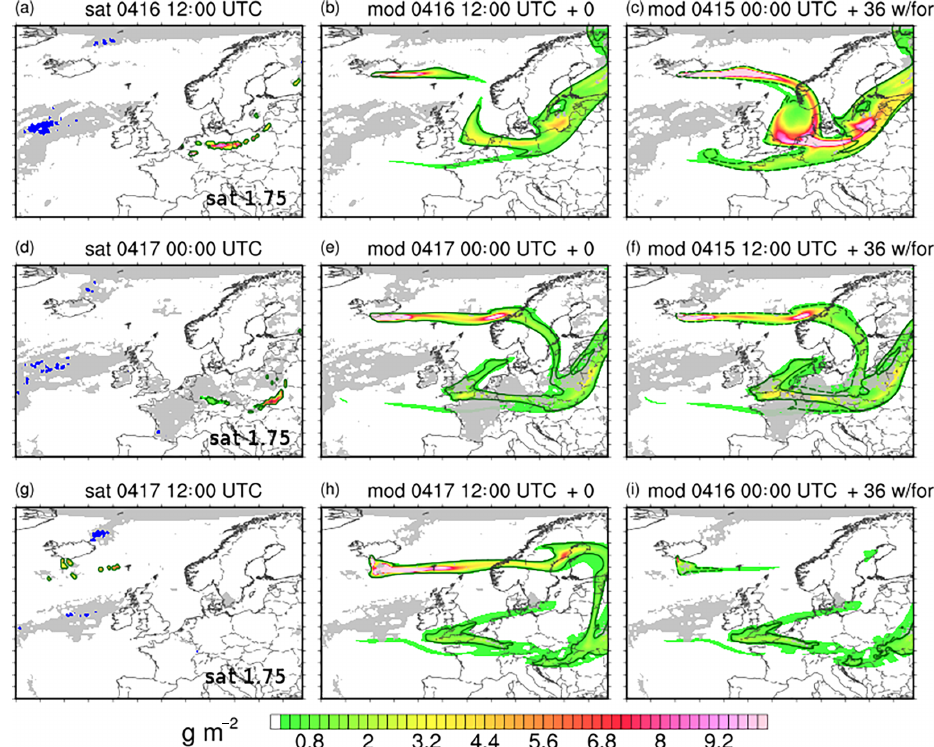
Figure 9. (a, d, g) SEVIRI satellite retrievals assuming the sat 1.75 size distribution on 16 April at 12:00UTC (a) , 17 April at 00:00UTC (d) , and 17 April at 12:00UTC (g) . Blue areas indicate where the satellite has false-positive detection of ash. (b, e, h) show model simulations with a posteriori emissions calculated from the inversion assuming the 1.75 size distribution, using all satellite retrievals up until the time indicated above the figure (same as satellite). (c, f, i) show model forecasts for the same time as the two first columns but with a posteriori emissions calculated with satellite observations up to 36h before and a forecast emissions term for the remaining 36h. The green line encircles objects used for SAL (structure, amplitude, and location) scoring, where ash exceeds the 0.5gm − 2 limit for model and observed ash. Ash released in the forecast term is shown with a dashed line (only the rightmost